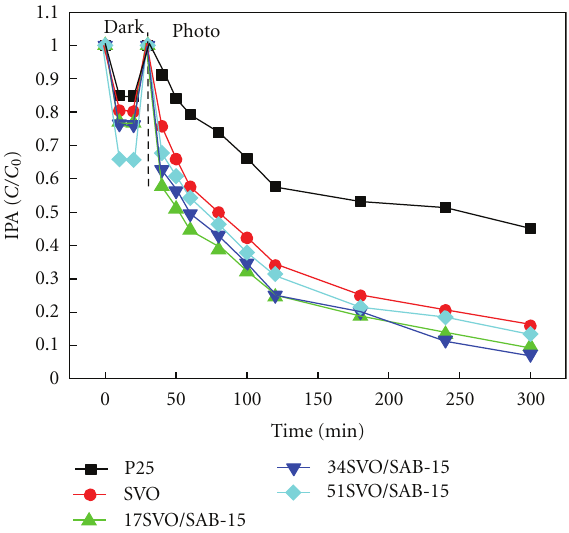
Figure 6: Time-dependent concentrations of CO 2 as final product under visible-light